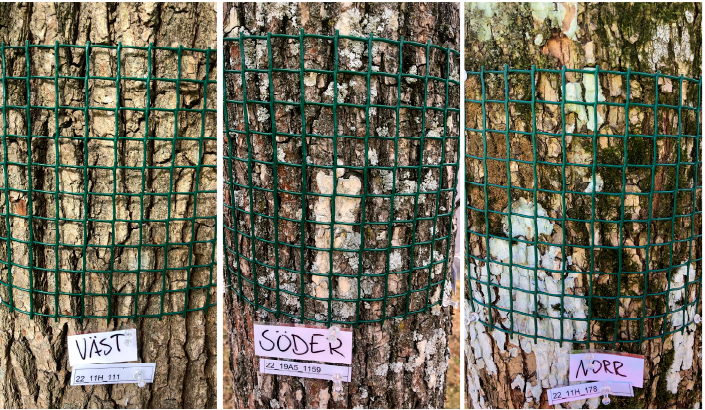
Figure 1. In the epiphyte cover survey, a sampling grid (20 cm × 20 cm) divided into 100 squares was positioned in the four cardinal orientations (N, E, S, and W) on each tree. The frequency (occurrence within squares) of epiphytic growth was determined. Photo: Tobias Hansson.